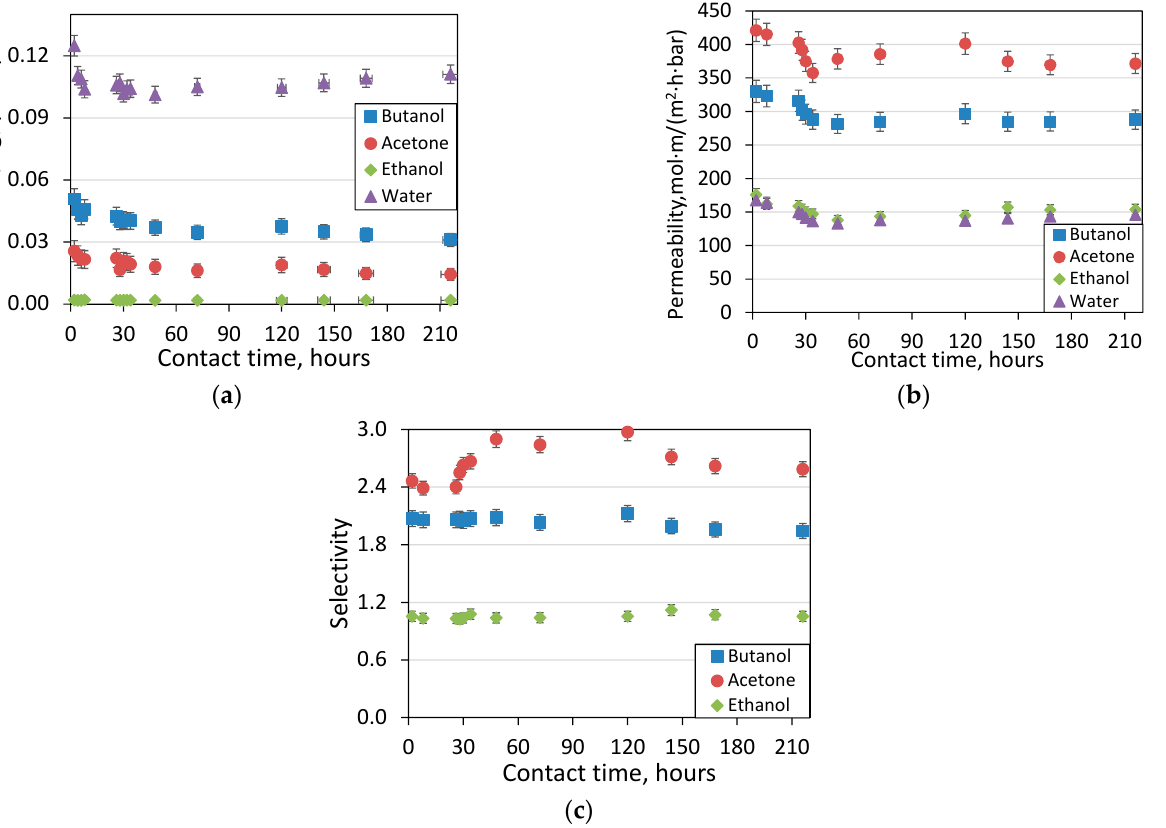
Figure 13. Dependence of partial fluxes of components ( a ), permeability ( b ), and selectivity ( c ) on the membrane contact time with ABE-fermentation broth.